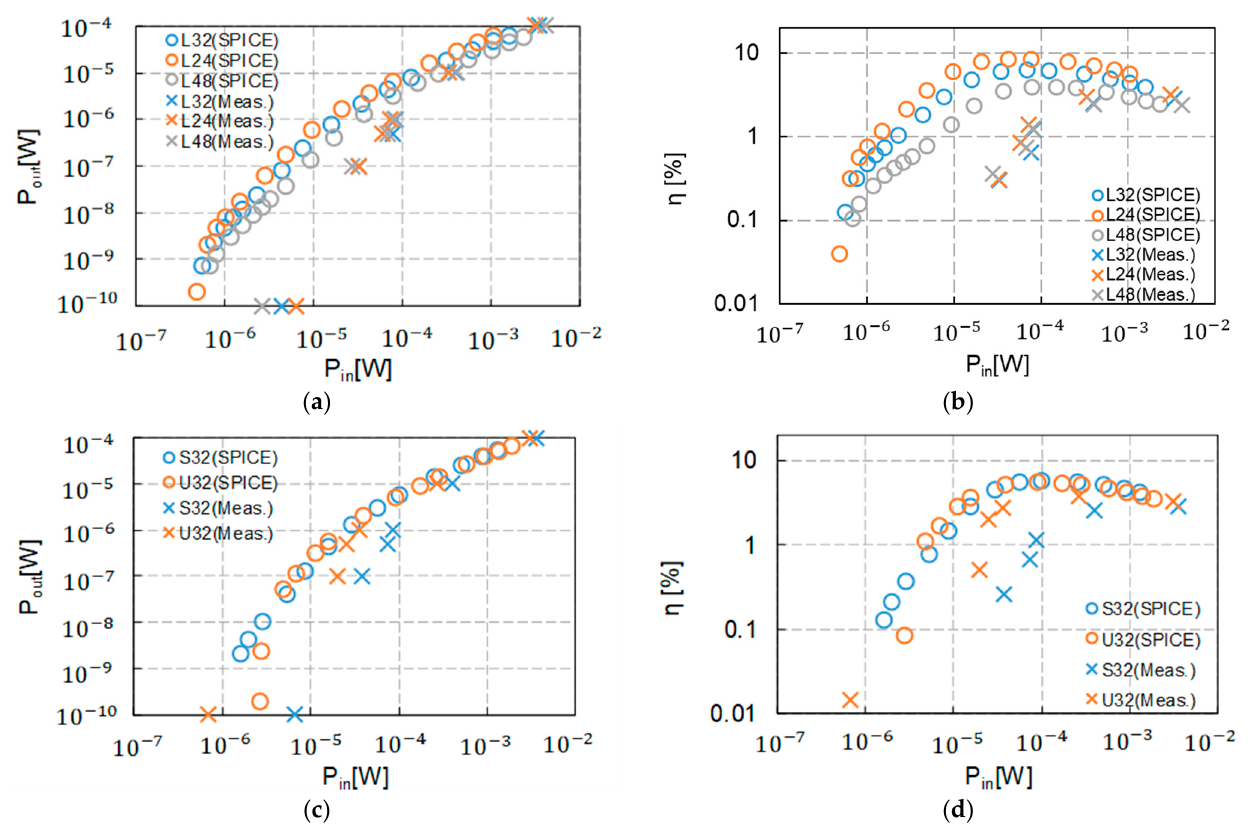
Figure 14. Comparison of input/output characteristics: ( a ) P in – P out of L24, L32 and L48, ( b ) η − P in of L24, L32 and L48, ( c ) P in – P out of S32 and U32, and ( d ) P in − η of S32 and U32.